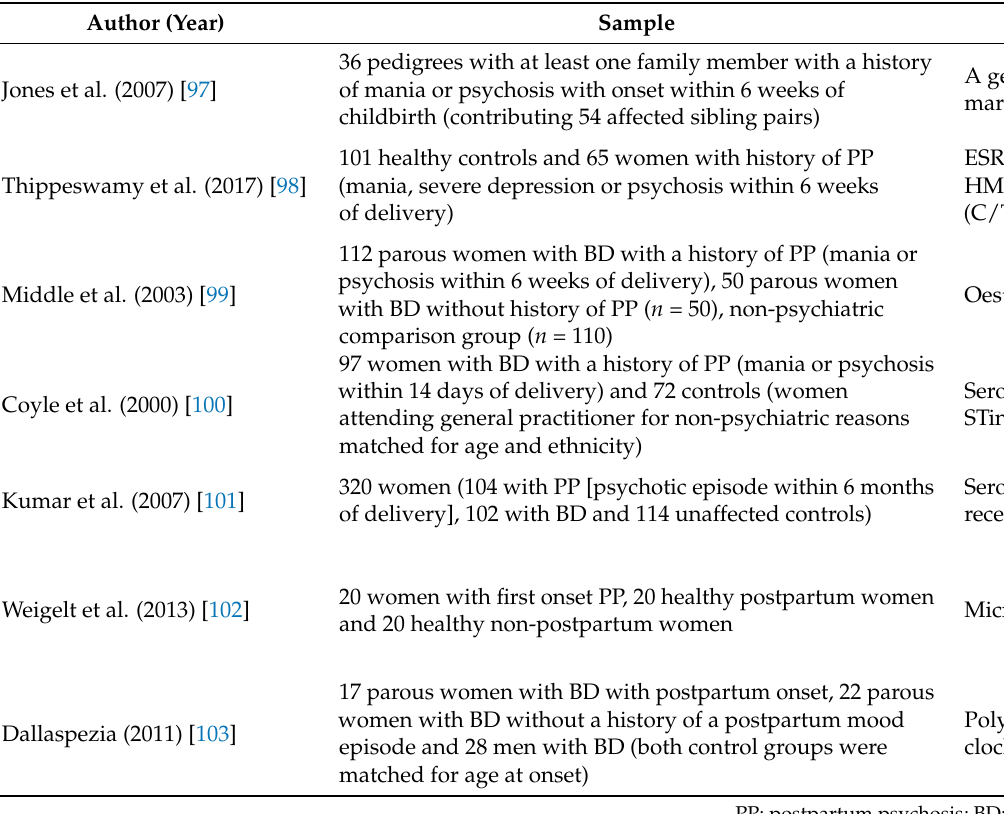
Table 2. Summary of literature identifying potential genetic risk markers for postpartum